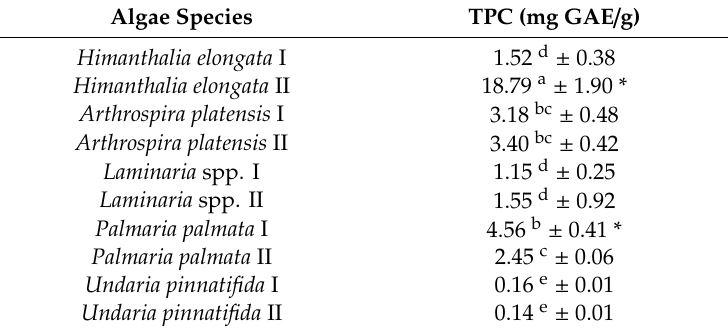
Table 1. Total phenolic content (TPC) of seaweed extracts expressed as mg GAE /